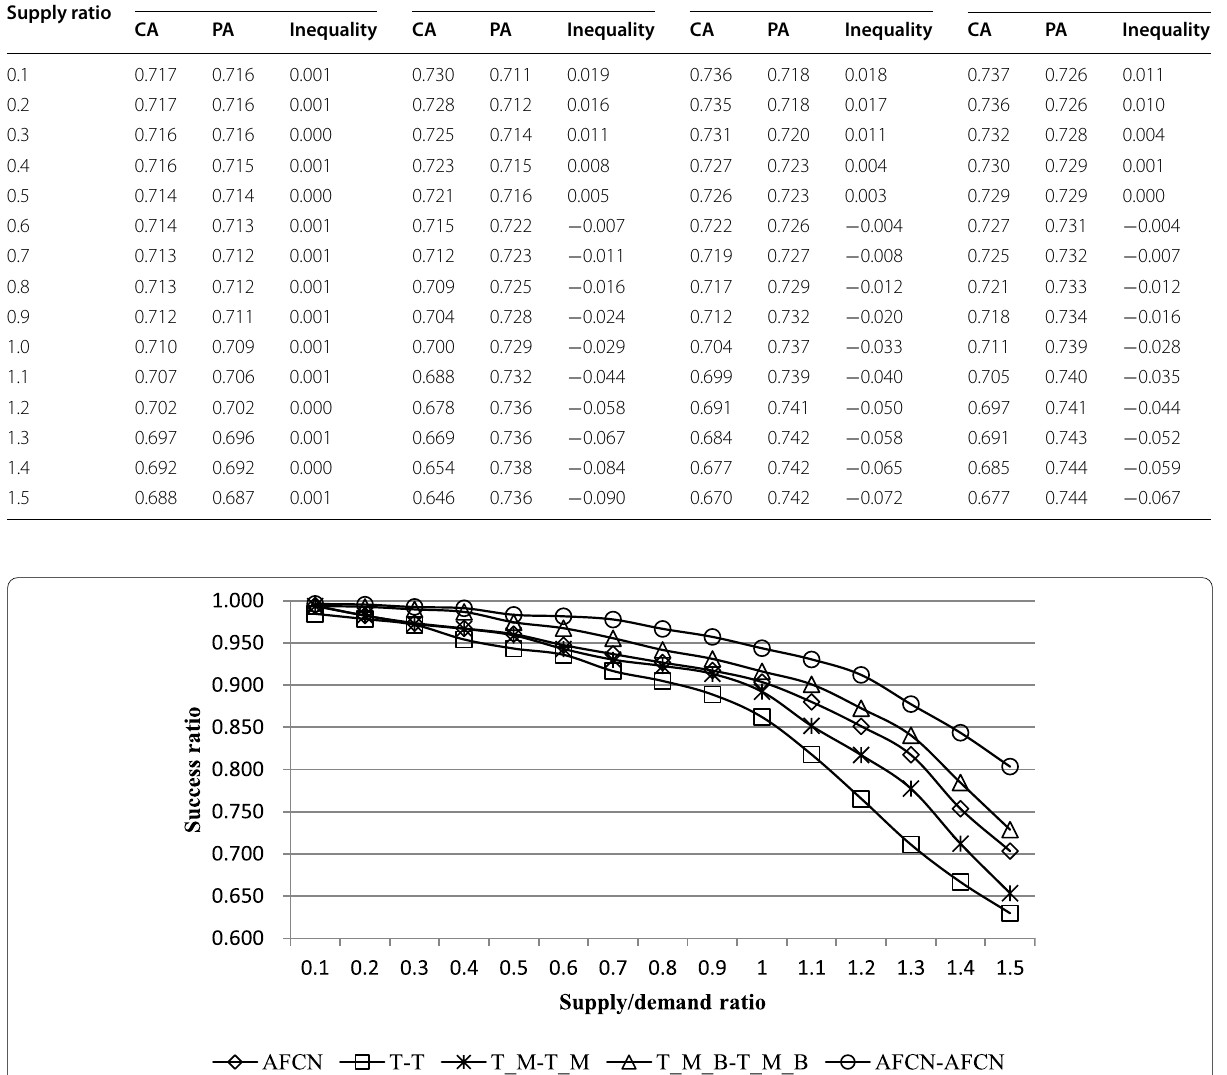
Table 3 Inequality degree between the CA and PA for different negotiation models Demand/ T-T Supply ratio